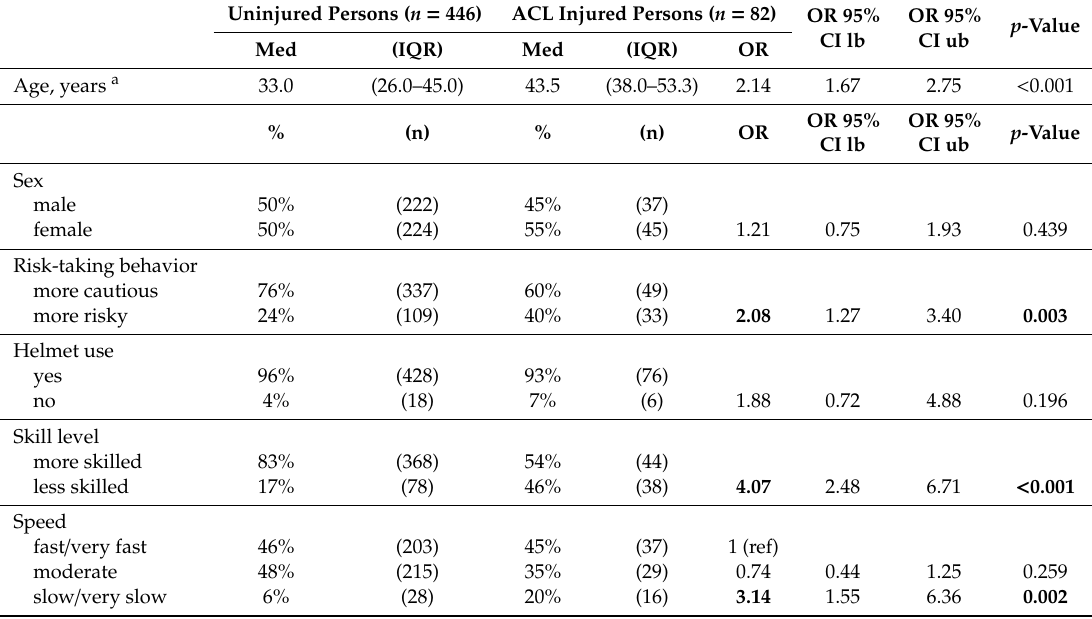
Table 2. Simple regression analysis regarding factors associated with the dependent variable ACL injury (0: uninjured, 1: ACL injured) among recreational skiers.